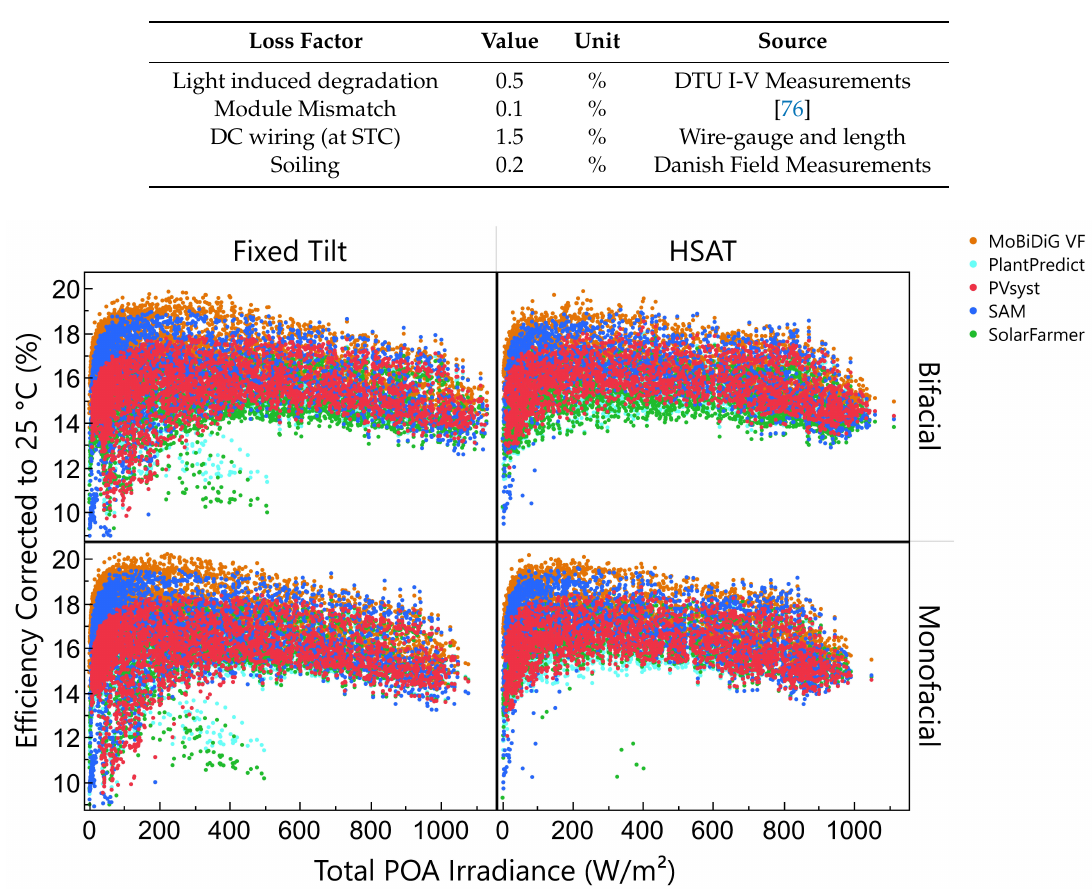
Table A5. DC losses used in the simulations.